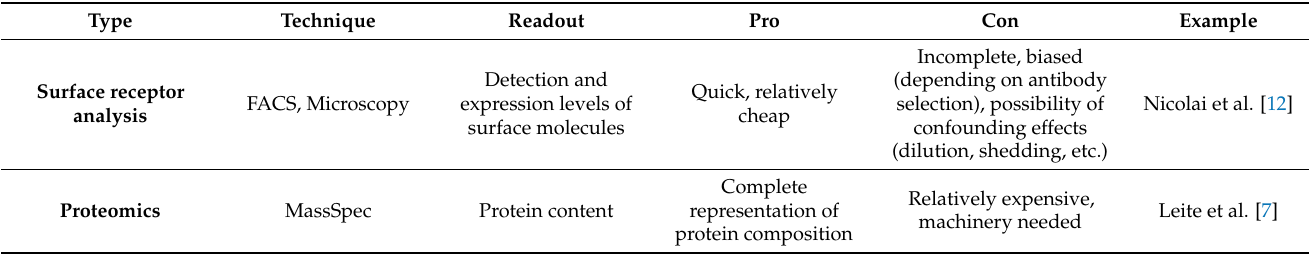
Table 1. Techniques (selection) for cell phenotype